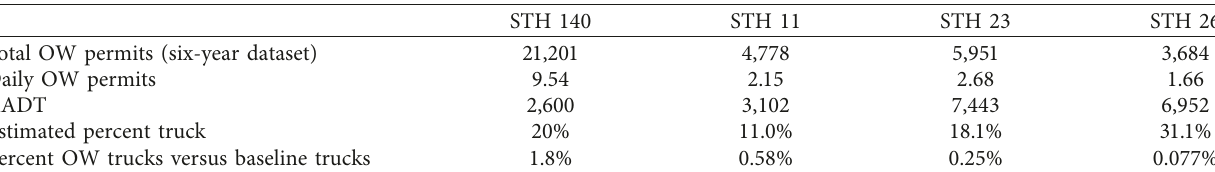
Figure 3: Most heavily travelled highways by single-trip OW permit trucks, with selected test highways highlighted. Table 1: Truck and OW permit traffic levels at investigated test